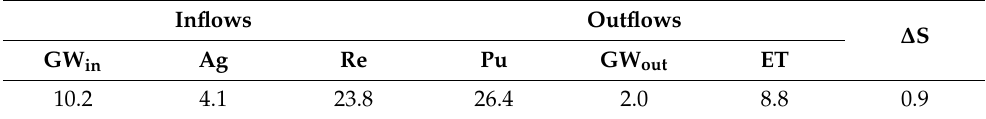
Table 1. CONAGUA’s WBM components for 2020 (MCM/year). Source: CONAGUA (2020) [23].